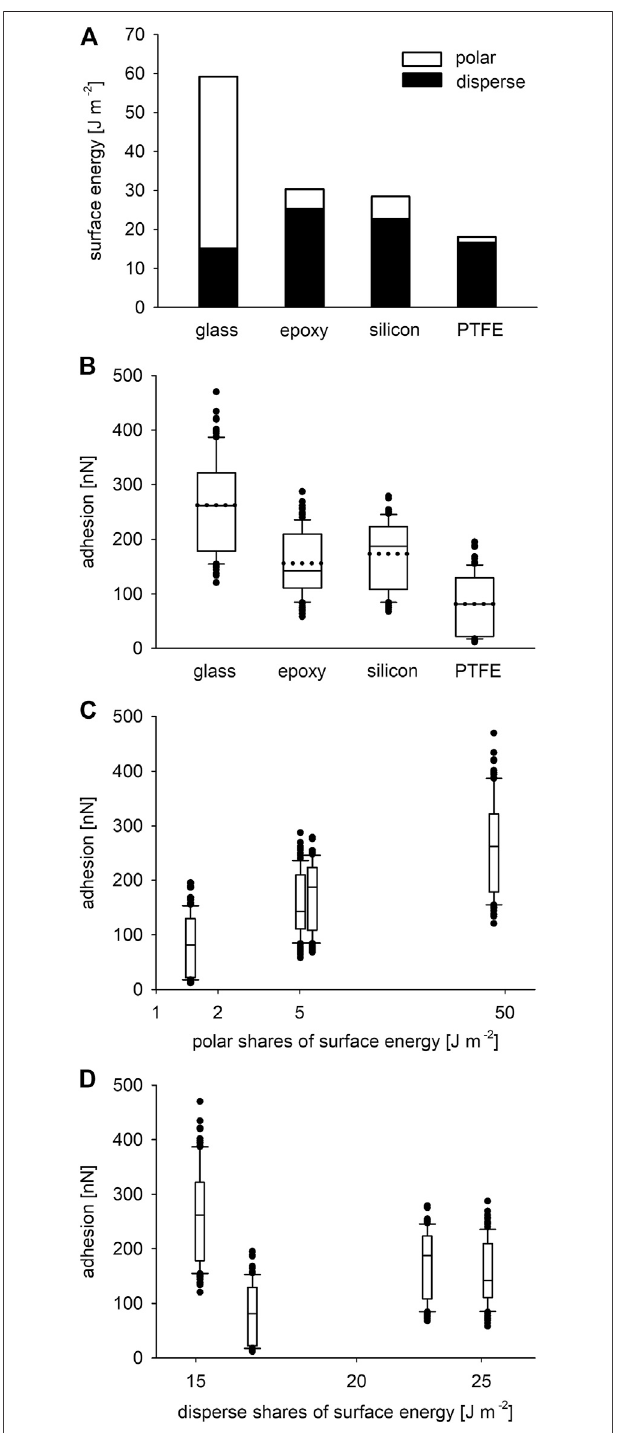
FIGURE 5 | (A) Summed up disperse and polar shares of the surface energies of the four tested smooth substrates (mean values from 10 measurements each). (B) Adhesion force of the three adhesive setae on the four smooth substrates after 500 nN loading perpendicular to the